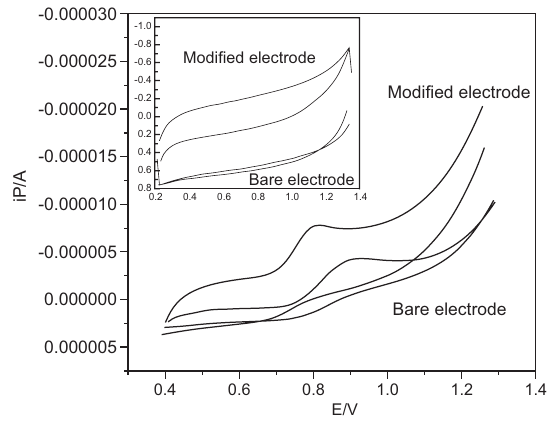
Figure 2 Cyclic voltammograms of bare electrode and modifi ed